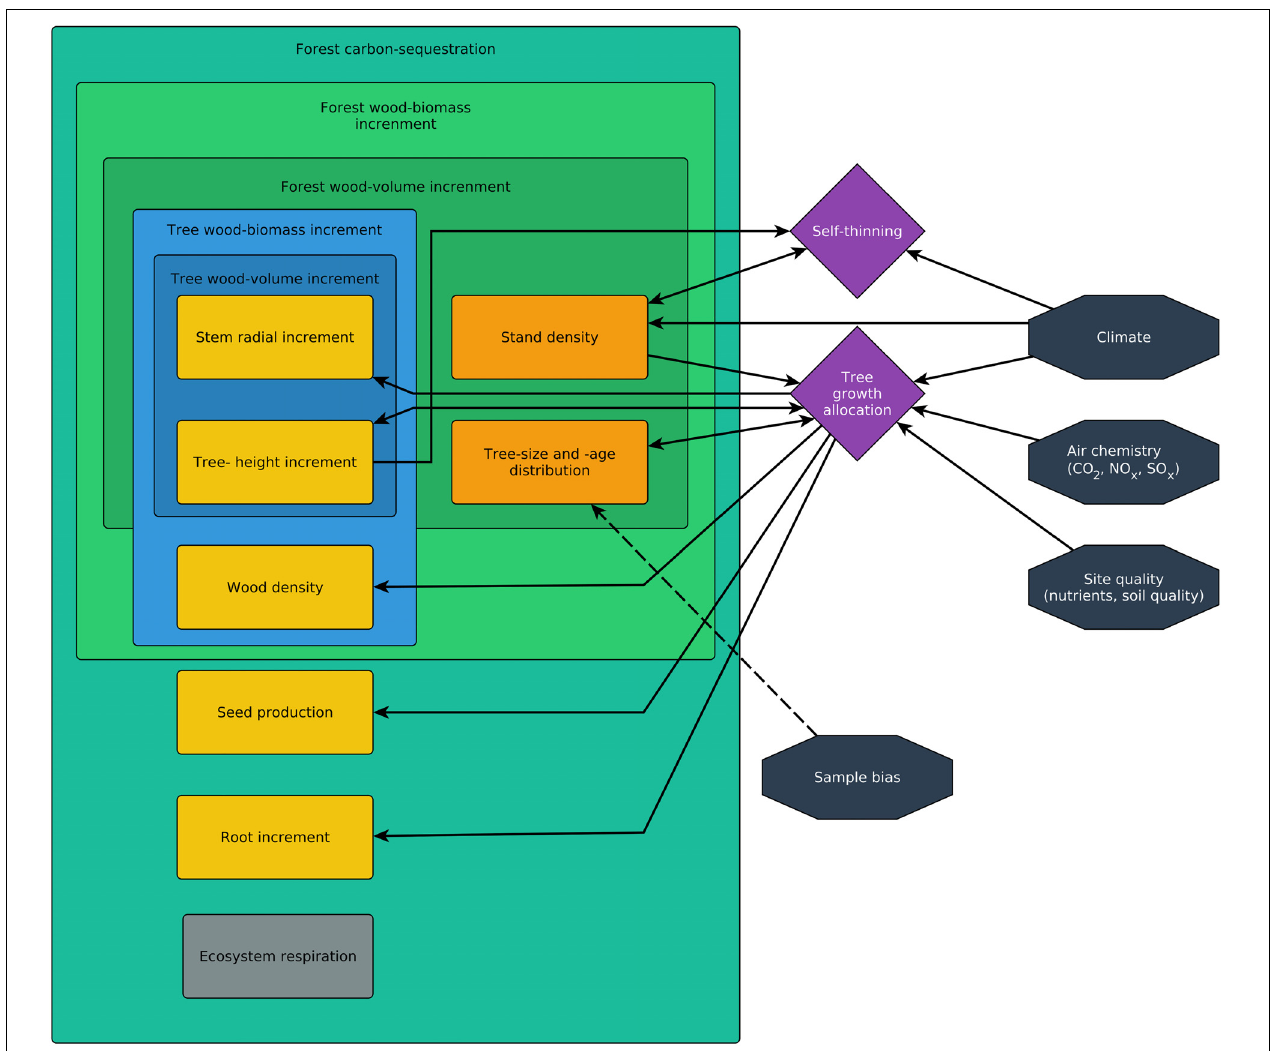
FIGURE 3 | This simplified schematic model shows how different types of growth rates are connected. Arrows indicate the effect of one variable or process on another and highlight the direct and indirect effects that connect growth rates, environmental conditions, and sample biases (black), processes (purple), as well as forest and tree parameters